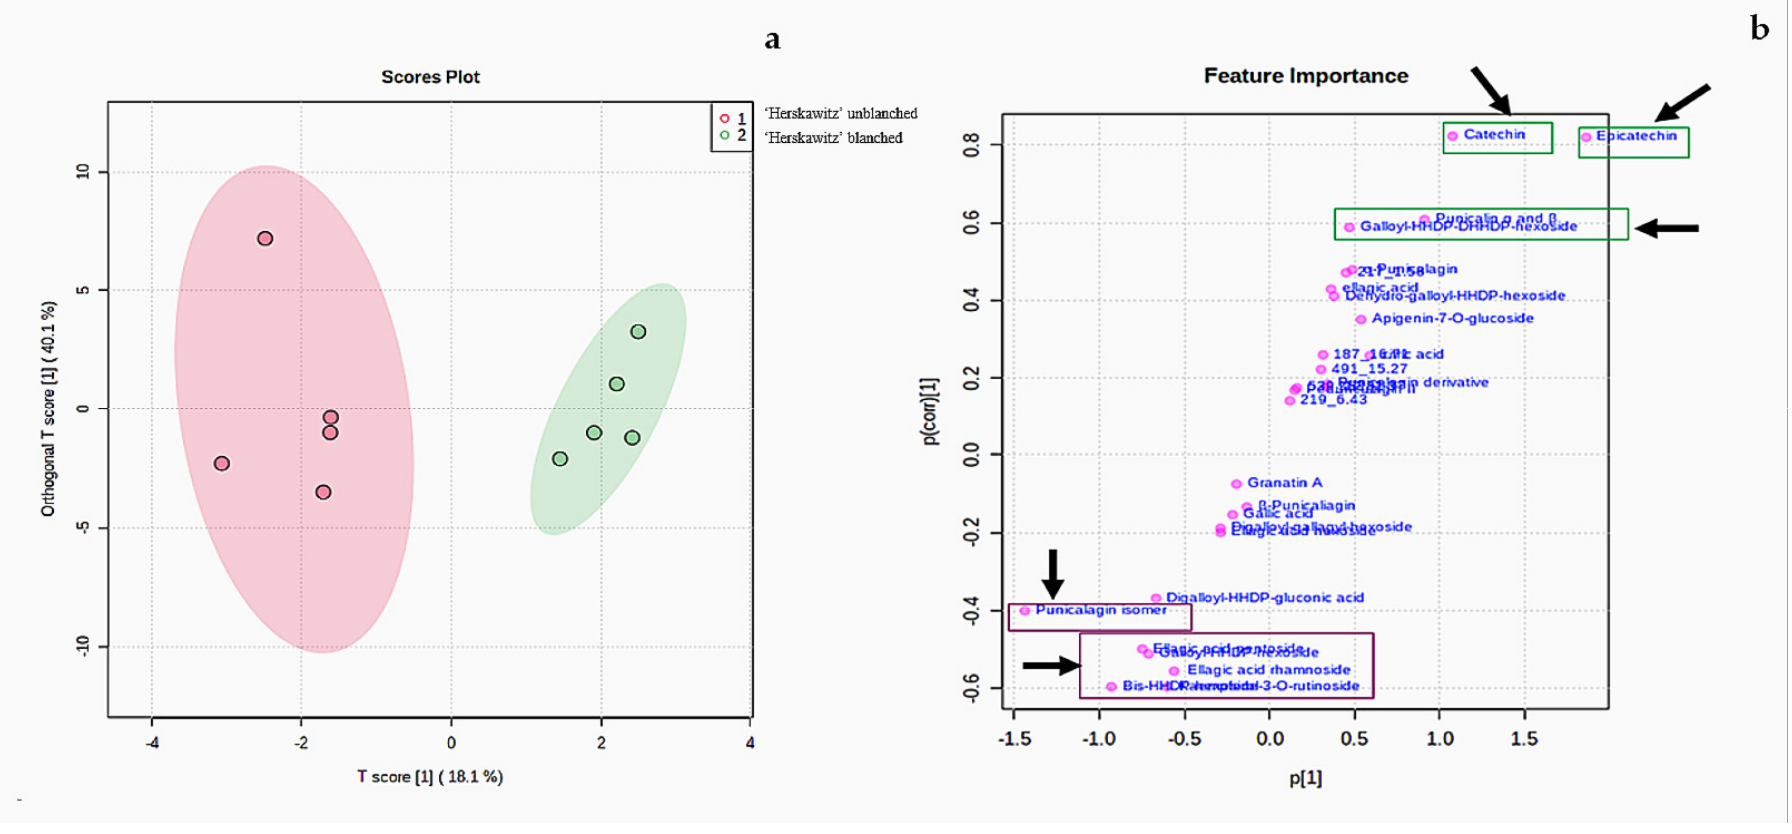
Figure 3. ( a ) Orthogonal partial least squares discriminant analysis (OPLS-DA) for ‘Herskawitz’ unblanched (purple colour) and ‘Herskawitz’ blanched (green colour) peel samples. ( b ) S-plot of orthogonal partial least squares discriminant analysis of LC-MS spectra for ‘Herskawitz’ unblanched and ‘Herskawitz’ blanched peel samples showing the compounds that are important discriminants.